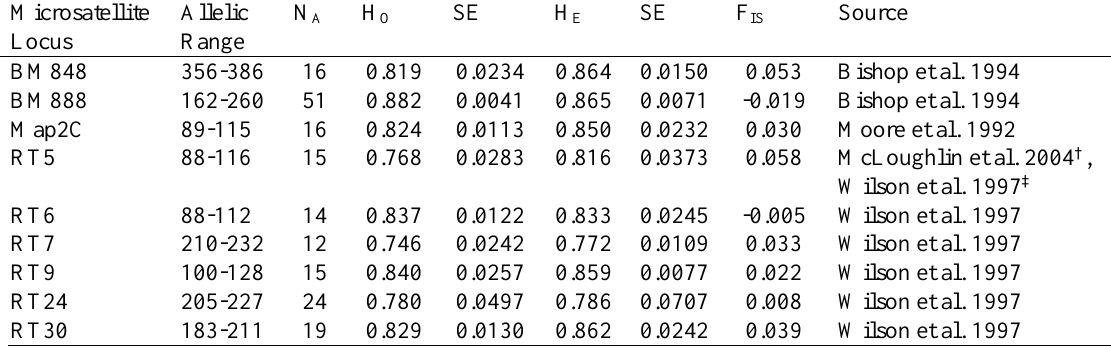
Table A2.1. Summary of genetic diversity estimates for each microsatellite loci including allelic size range in base pairs, number of alleles (N A ), observed (H O ) and expected (H E ) heterozygosity, F IS estimates and standard errors (SE) for caribou genetic data from the Northwest Territories, Canada. The original references for each loci are